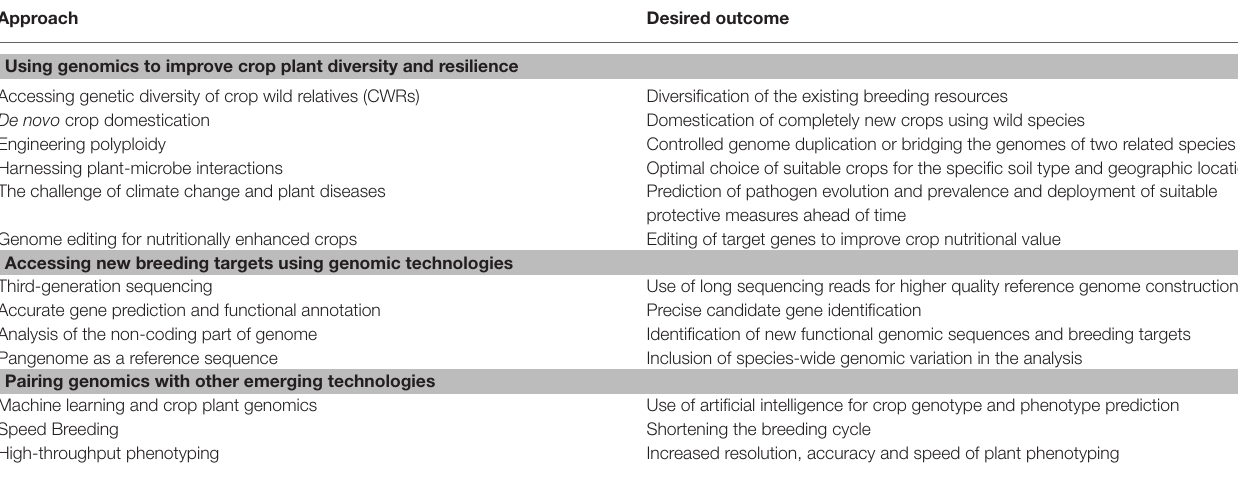
TABLE 1 | Summary of different approaches, which can be used to improve crop diversity and resilience. Approach Desired outcome Using genomics to improve crop plant diversity and resilience Accessing genetic diversity of crop wild relatives (CWRs)